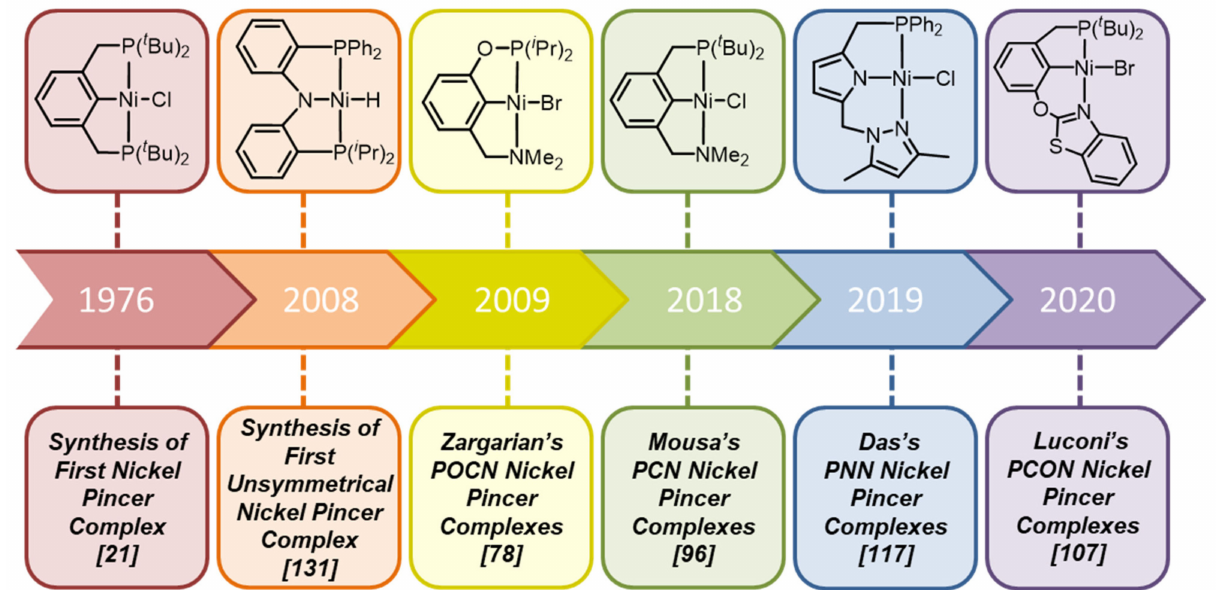
Figure 11. Historical timeline for unsymmetrical pincer nickel